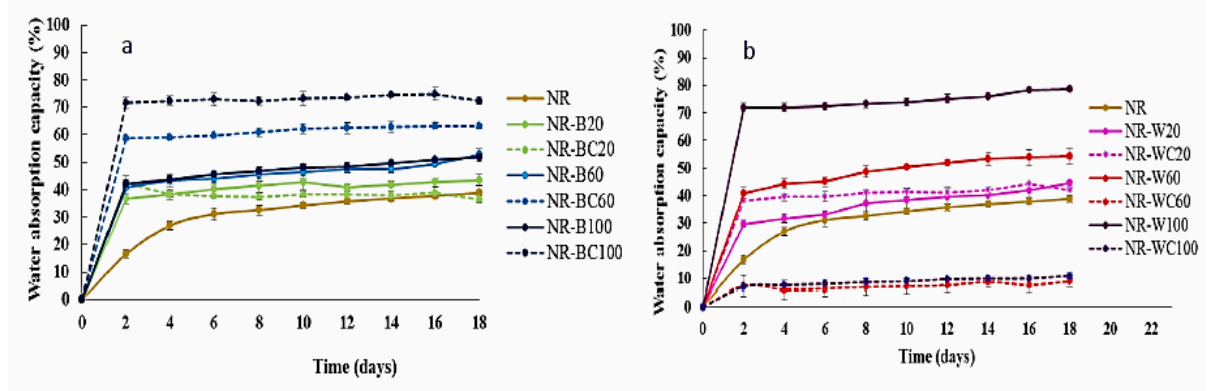
Figure 8. Water adsorption capacity of NR, NR–B, NR–BC ( a ) and NR–W, NR–WC ( b ).